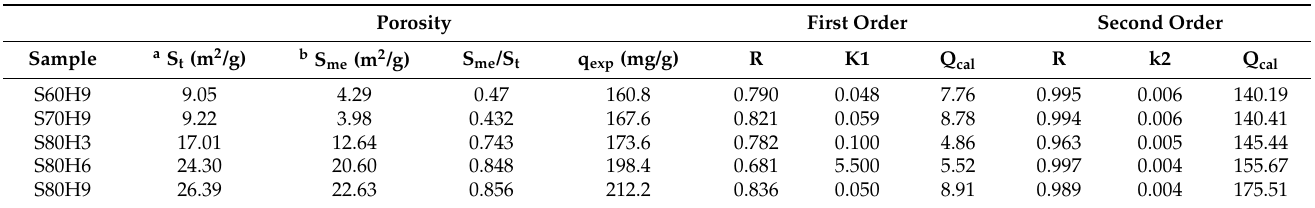
Table 7 summarizes the kinetic analysis data based on the pseudo-first order and the pseudo-second order equations. The plot between ln(qe − qt) versus t for the pseudo- first order model (Figure 9a) and t/qt versus t plot for the pseudo-second order model (Figure 9b) were carried out to obtain the regression coefficient value related to linearity (R 2 ). The pseudo-first order plot showed that the R 2 values for all the samples were within 0.681–0.836. Meanwhile, for the pseudo-second order plot, the R 2 value of each sample was within 0.963–0.997, thus indicating that the adsorption of Pb 2+ on sodalites followed the pseudo-second order kinetic model. Table 7. Porosity and kinetic results of Pb 2+ adsorption on SOD samples with CTABr.